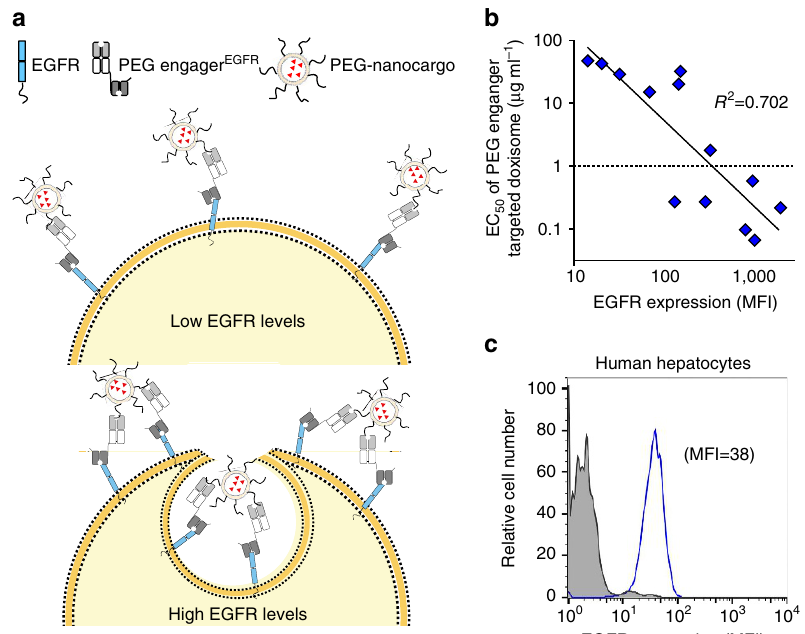
Figure 8 | EGFR levels correlate with PEG engager-directed Doxisome therapy. ( a ) The proposed mechanism of PEG engager-mediated internalization of PEGylated nanoparticles. ( b ) Drug sensitivity to PEG engager-targeted Doxisome (EC 50 values) is plotted against EGFR expression levels on cancer cell lines. ( c ) Live human hepatocytes were immunofluorescence stained with control antibodies (grey area) or anti-human EGFR antibodies (blue solid line) and then analysed on a flow cytometer. Mean fluorescence intensity (MFI). Half maximal effective concentration (EC 50